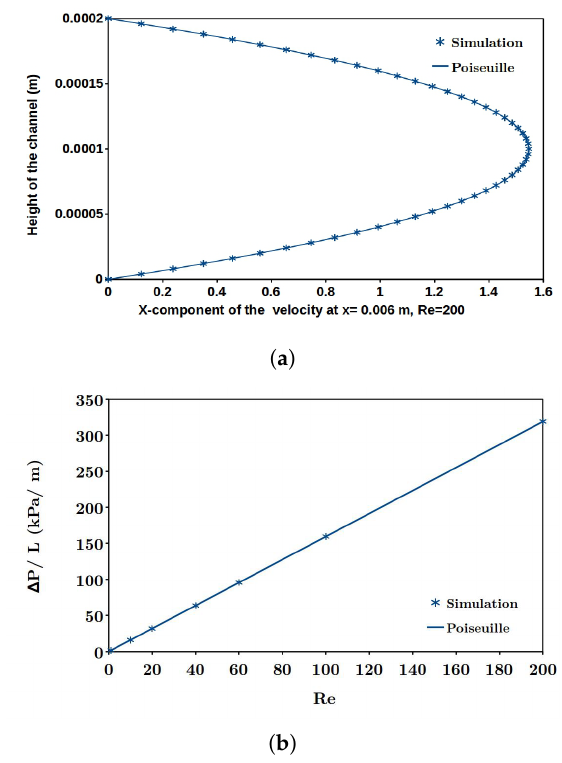
Figure 6. Verification of the numerical simulation with Poiseuille equation for pressure loss and velocity profile: ( a ) velocity profiles for analytical solution and simulation at Re = 200; and ( b ) pressure drop profiles across the inlet and outlet of the flat channel from analytical solution and